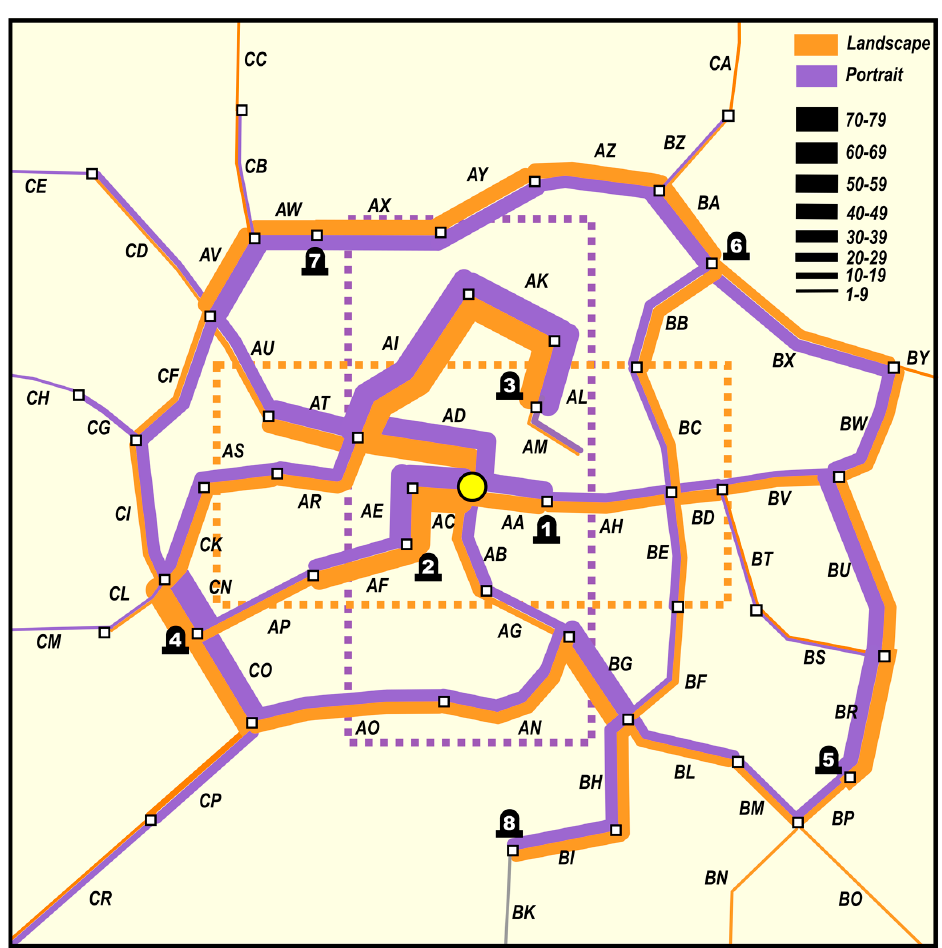
Figure 11. Comparative flow map with the presentation of the moving number along individual road sections (two-letter description of sections from AA to CR).